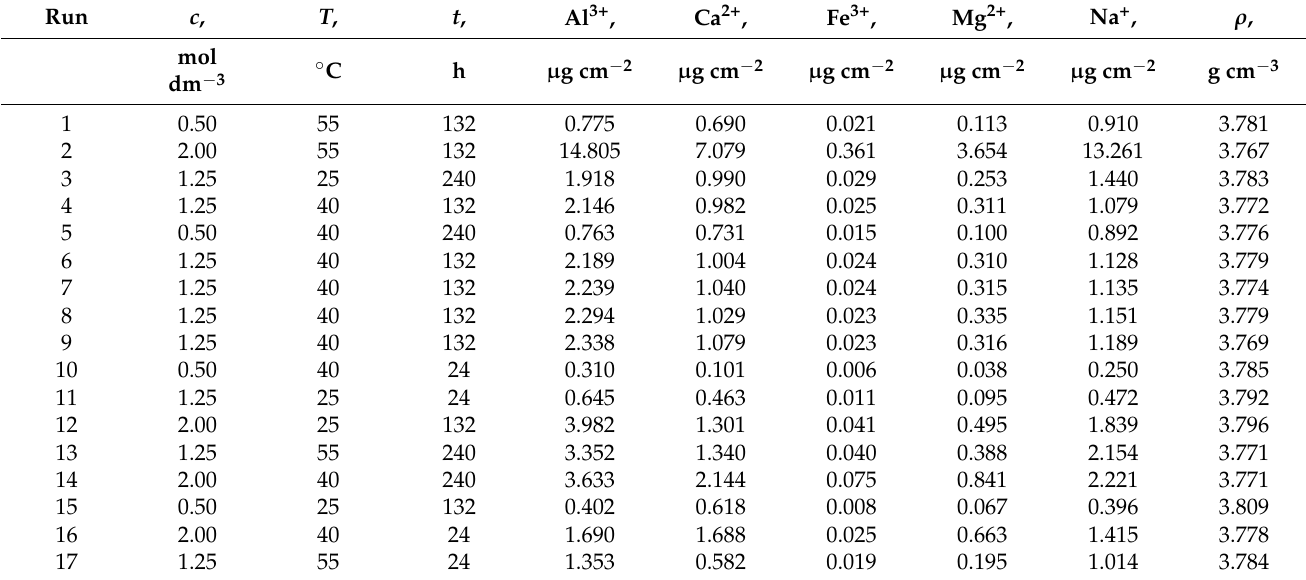
Table 5. All experimental values used for response surface plots and regression equations.